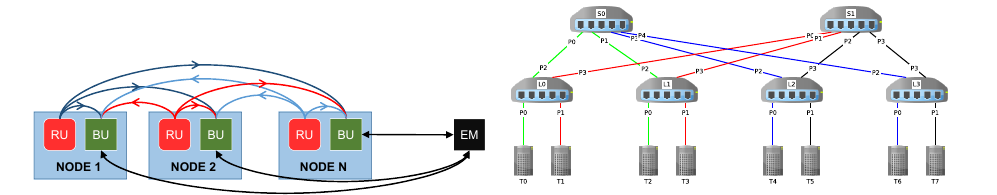
Figure 2. The logic representation of the LHCb Event Building process. The di ff erent arrows rep- resent the multiple fragments sent by the Readout Unit and gathered by the Builder Unit while the black ones the control messages to and from the Event Manager.